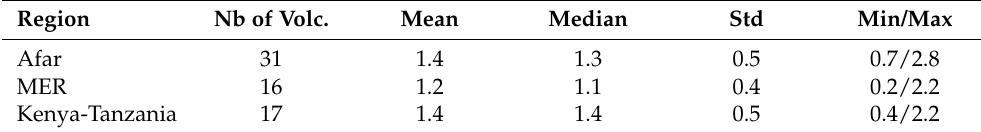
Table 1. Statistical values (mean, median, standard deviation, minimum and maximum values) associated with the temporal noise σ A for each of the three EARS regions (Afar, MER, Kenya-Tanzania). Units are in centimetres. Region Nb of Volc. Mean